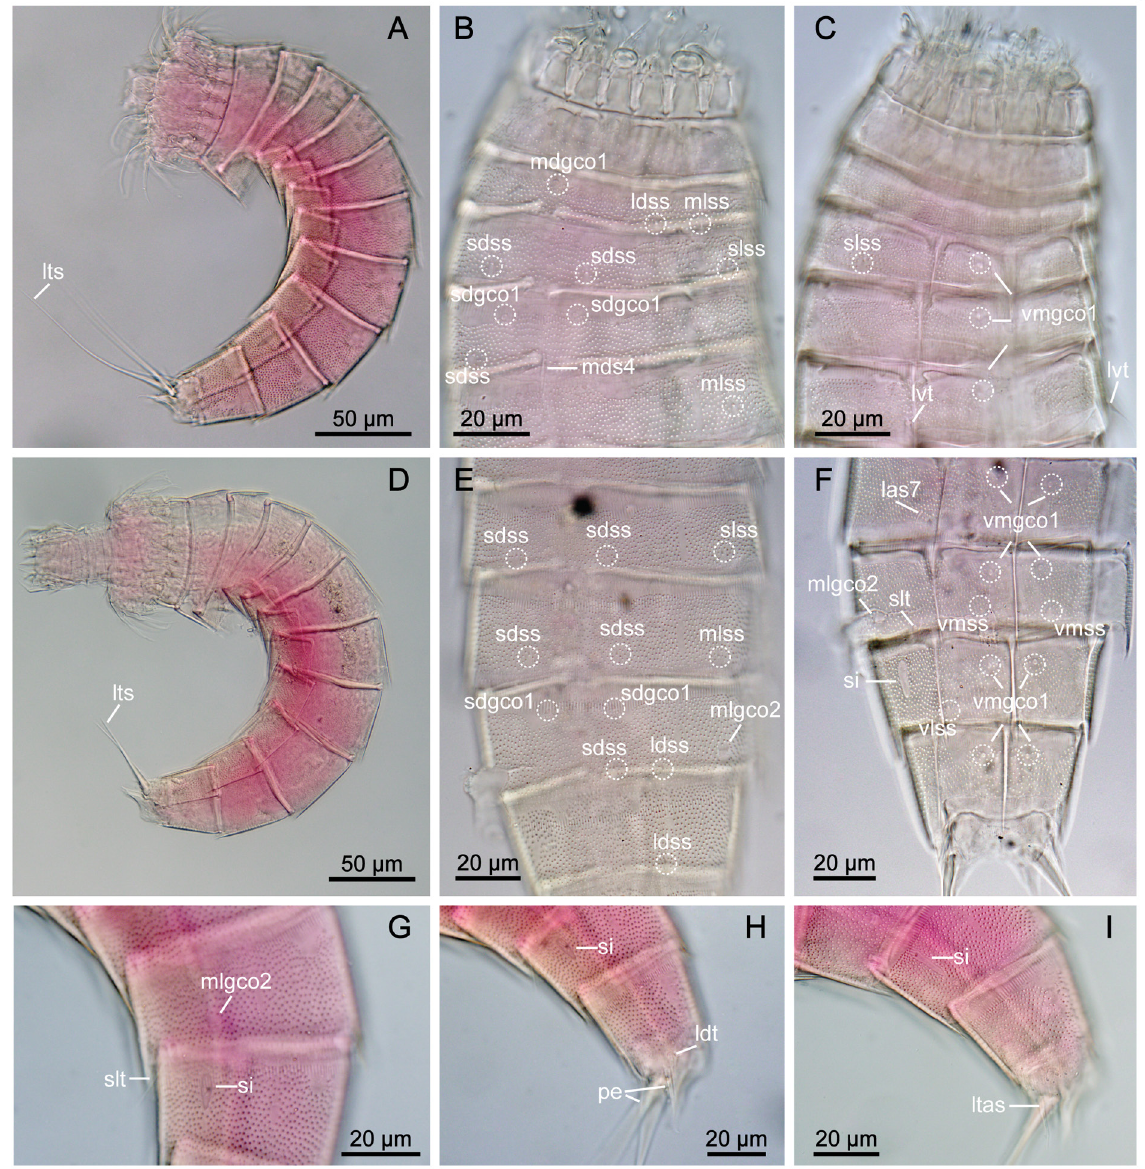
Fig. 3. Light micrographs showing overviews and details of Echinoderes blazeji sp. nov. A, G–H . ♂, paratype (NIWA-159401). B–C, E–F . ♂, holotype (NIWA-159400). D, I . ♀, paratype (NHMD- 917223). A . Lateral overview of male. B . Segments 1 to 5, dorsal view. C . Segments 1 to 5, ventral view. D . Lateral overview of female. E . Segments 6 to 9, dorsal view. F . Segments 7 to 11, ventral view. G . Segments 8 to 9, lateroventral view. H . Segments 9 to 11 of male, lateral view. I . Segments 9 to 11 of female, lateral view. Abbreviations: see Material